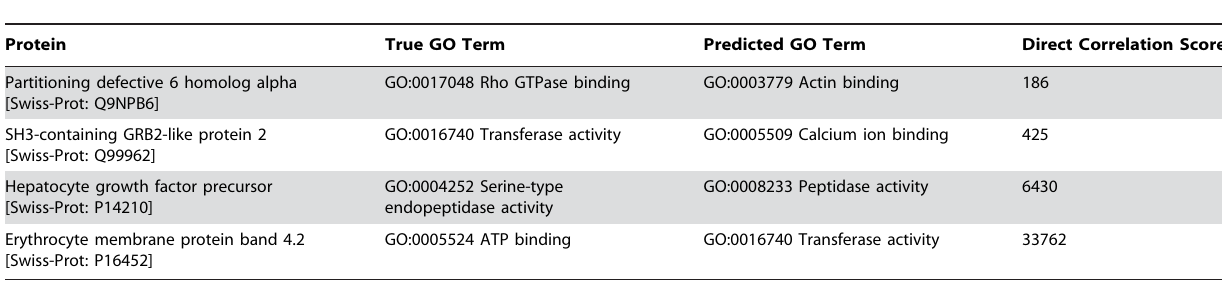
Table 4. Examples of proteins with high correlation scores